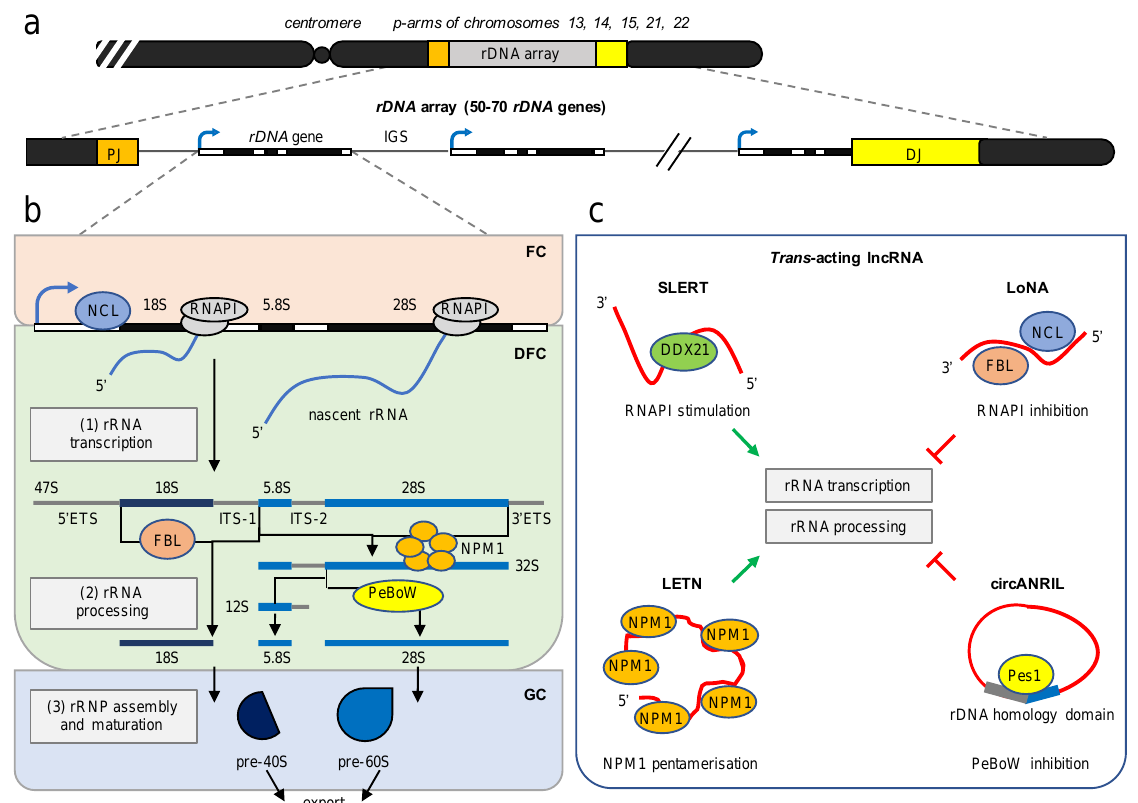
Figure 2. Structural and functional organisation of ribosome biogenesis by lncRNA. ( a ) Schematic of the rDNA array on the p-arms of five acrocentric chromosomes. PJ, proximal junction; DJ, distal junction; blue arrowhead, rDNA promoter; IGS, intergenic spacer. The transcription units are not to scale. ( b ) Ribosome biogenesis requires three major steps and occurs in the context of the nucleolar tripartite structure. (1) rRNA transcription requires synthesis of an rRNA precursor by RNAPI and occurs at the interface of the fibrillar center (FC) and the dense fibrillar component (DFC). (2) rRNA processing occurs in the DFC and involves a cascade of cleavage and trimming steps that remove ribosomal spacer sequences and produce mature 18S, 5.8Sm and 28S rRNA forms via 32S and 12S rRNA intermediates. 5′ ETS/ 3′ ETS, 5′ / 3′ external transcribed spacer; ITS-1/ITS-2, internal transcribed spacer-1/-2. NCL, Nucleolin; FBL, Fibrillarin; NPM1, Nucleophosmin 1; PeBoW, Pes1-Bop1-Wdr12 complex are major ribosomal synthesis factors. (3) The assembly and maturation of ribosomal ribonucleoprotein complexes (rRNPs) occur in the granular component (GC) and generate 40S and 60S ribosomal subunit precursors (pre-40S, pre-60S). ( c ) Examples of trans-acting nucleolar lncRNA. SLERT and LETN stimulate (green arrowhead) rRNA synthesis by exclusion of the nucleolar DEAD-box helicase 21 (DDX21) from RNAPI and scaffolding the pentamerisation of NPM1, respectively. LoNA and circANRIL inhibit (red block) rRNA synthesis by sequestration of FBL, NCL, and Pes1, respectively. Refer to the main text for details.